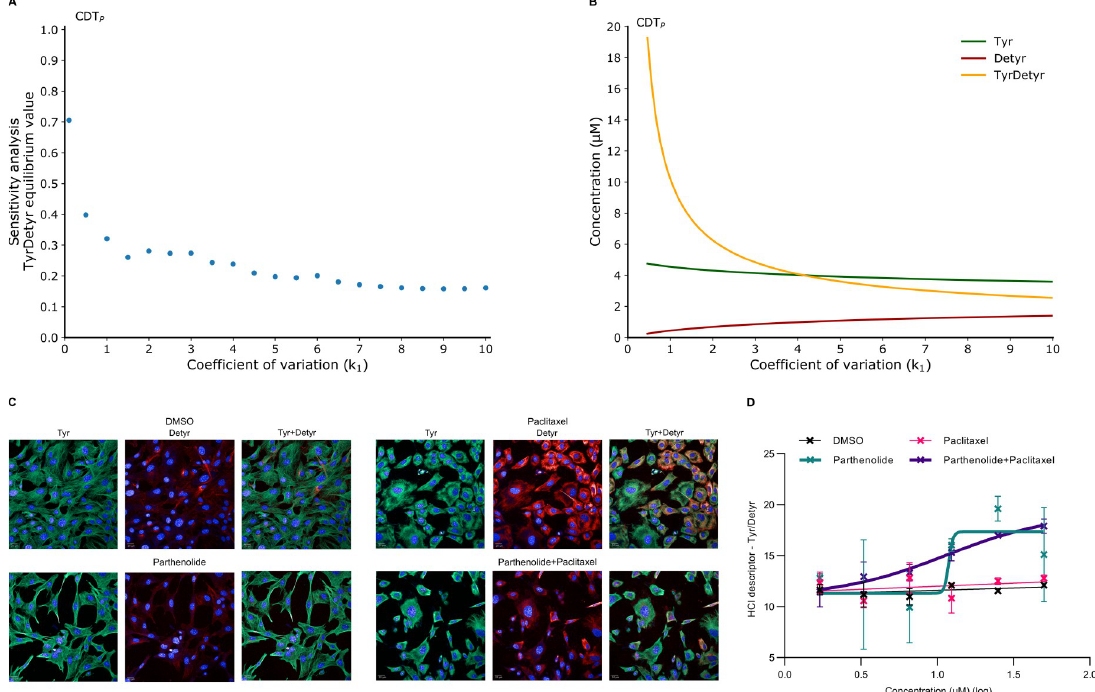
Fig 4. Mathematical model predictions of the detyrosination inhibition with experimental validation in proliferative cells. ( A ) Sensitivity analysis of the equilibrium value of TyrDetyr obtained for different coefficients of variation of the kinetic parameter k 1 in the computational model CDT P , indicating that the equilibrium value of TyrDetyr is sensitive for strong variation of k 1 . The BIOCHAM command used is: sensitivity(F(G(TyrDetyr = x)), [k1], [x -> 10], robustness_coeff_var: c) . where c is the robustness coefficient value. ( B ) Dose response diagram from the CDT P model by varying the kinetic parameter k 1 . The BIOCHAM commands used are: change_parameter_to_variable(k1), dose_response(k1, 0, 10, time:100, show:TyrDetyr) . The BIOCHAM command draws a dose-response diagram by linear variation of the initial concentration (the dose) of the input object, here k 1 , and plotting the output object (the response), here the molecular species: Tyr, Detyr and TyrDetyr, showing an increase of the tyrosination status with a decrease of k 1 . ( C) Compounds screening in dose response of the chemical compound parthenolide. Representative images showing immunostaining of Tyr (green) and Detyr (red) on MEF cells pretreated with or without paclitaxel. Compound concentrations: Parthenolide (1.2 μ M (log)), Paclitaxel (5 μ M), Parthenolide + Paclitaxel (1.2 μ M (log) + 5 μ M). Cells were co-stained with Hoechst. Scale bars represent 20 μ m. There was no extraction for free tubulin and the visualization of co-localization is potentially impacted. ( D ) Dose response diagrams of the tyrosination status from 4 conditions: DMSO, Paclitaxel, Parthenolide and Parthenolide+Paclitaxel, showing that the tyrosination status increase by inhibiting the detyrosination reaction. Parthenolide concentrations are indicated on the x-axis. Paclitaxel concentration is fixed to 5 μ M. We observe that the parthenolide and DMSO error bars overlap at concentrations above 1.5 μ M (log). At this parthenolide concentration, the cell morphologies are indeed altered, cytoplasms are reduced, and the cells appear to be highly